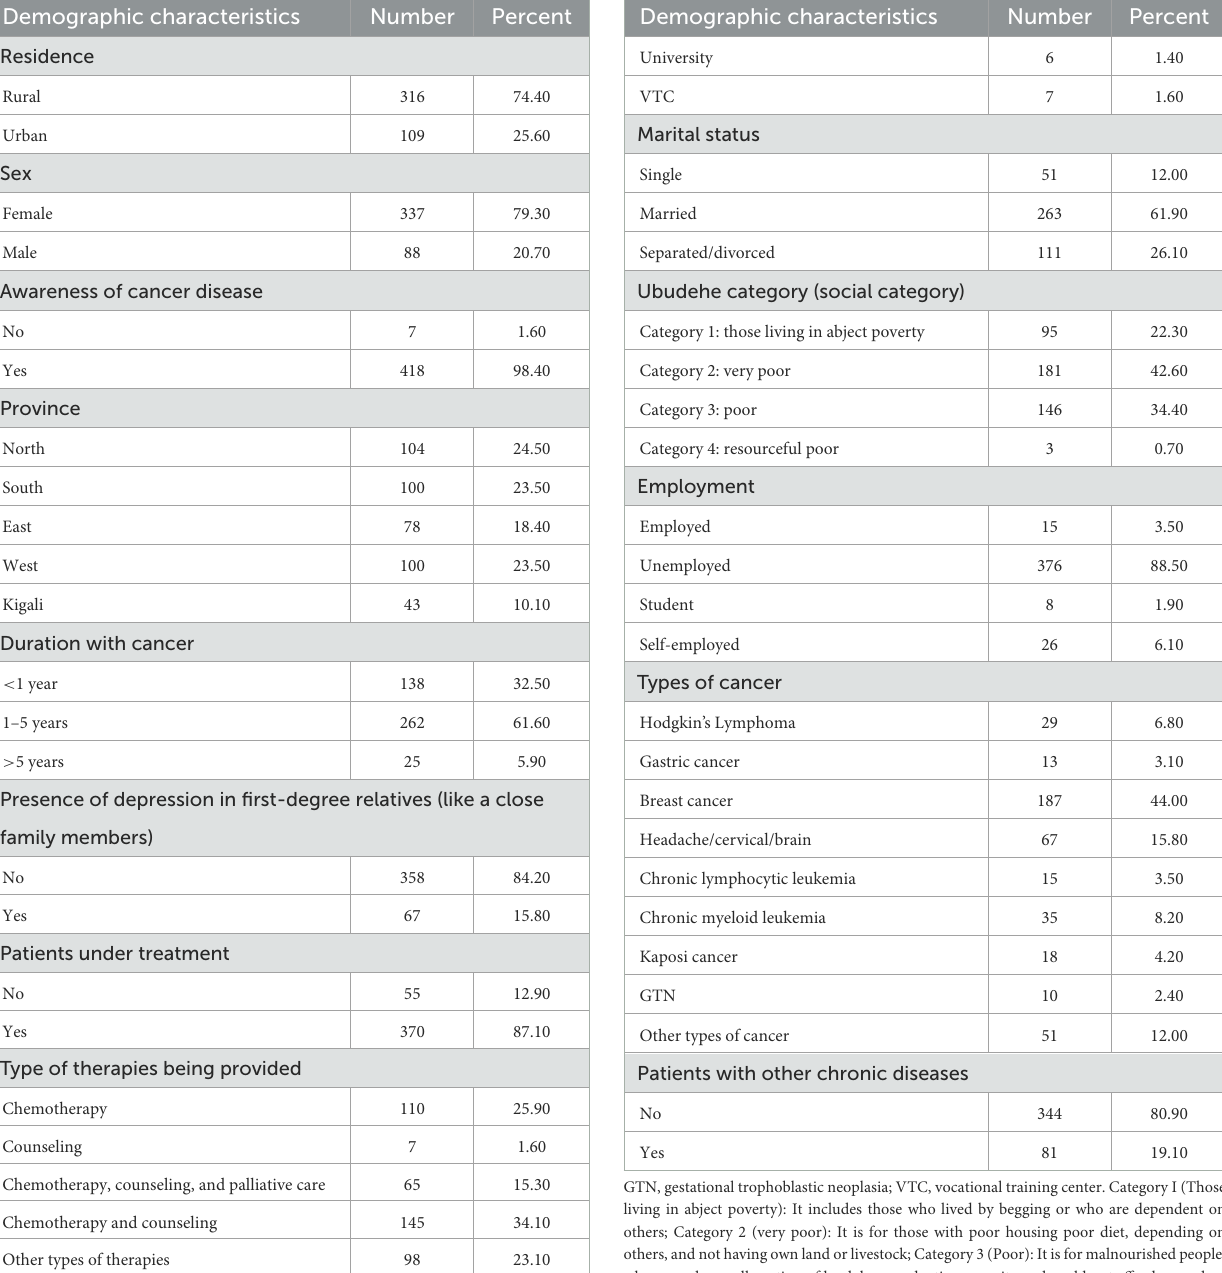
TABLE 1 Description characteristics of the patients with cancer ( n =